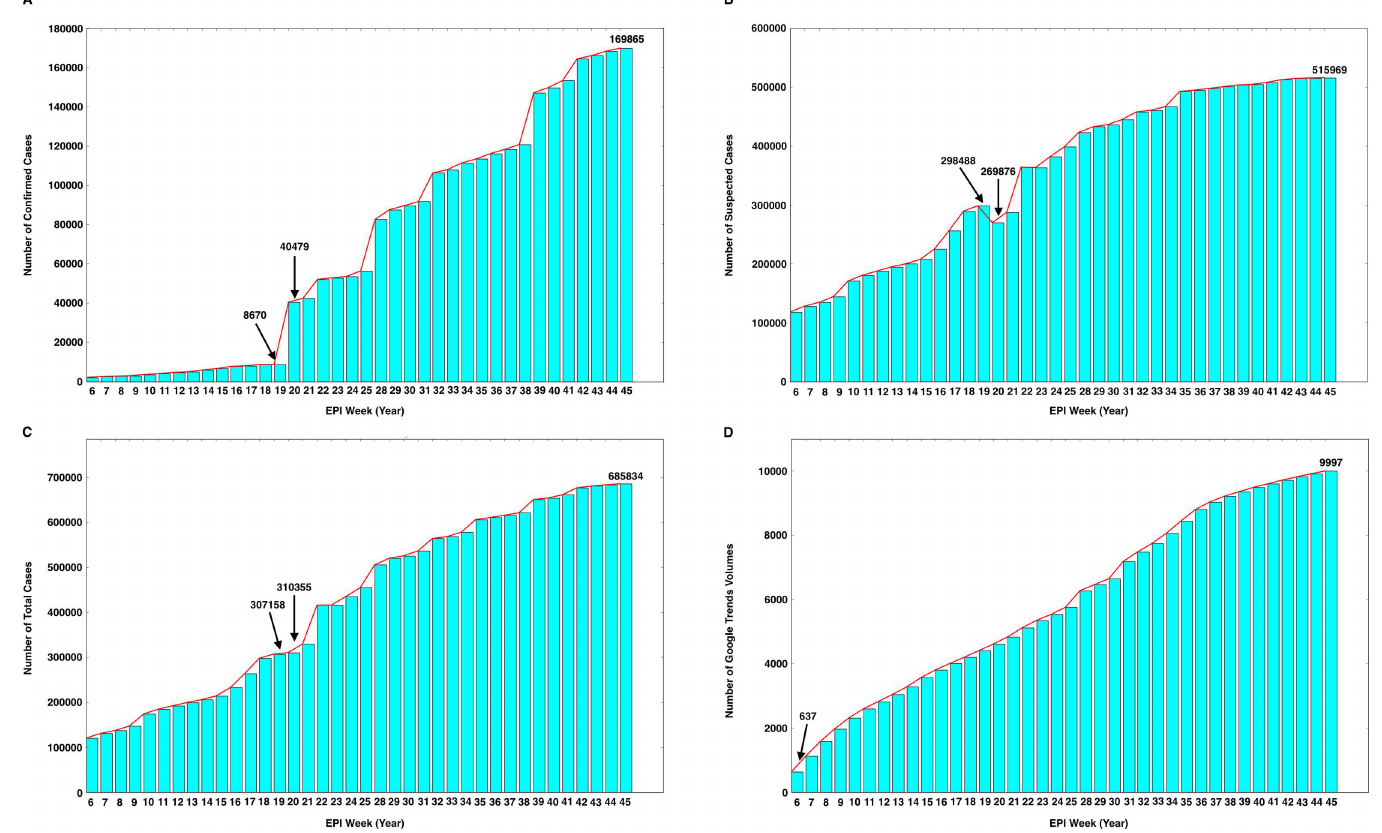
Fig 2. Time series plots of the number of reported ZIKV confirmedcases (A), suspected cases (B), total cases (C) and the accumulatedGoogle search volumes (D) duringthe ZVD epidemic from 12 February to 9 November 2016 (Yearly EPI Week 6 to